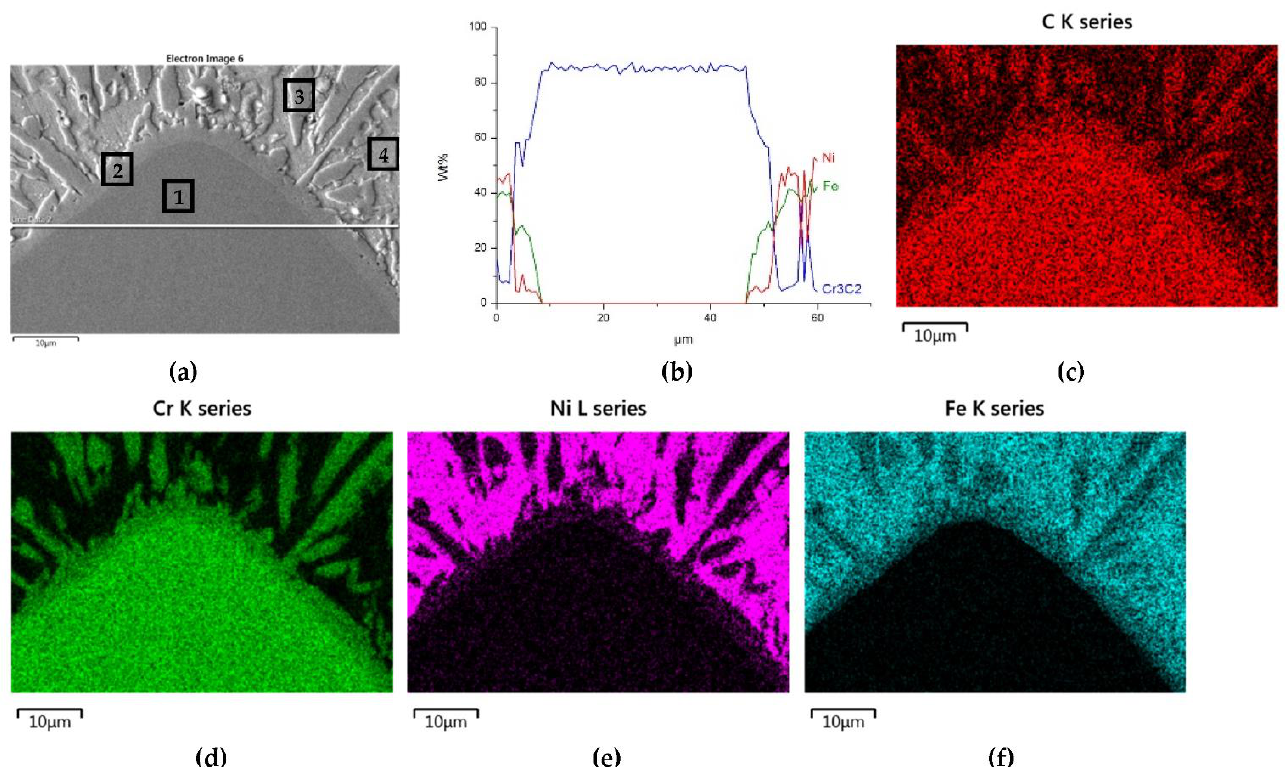
Figure 13. NiBSi-Cr 3 C 2 layer: SEM micrograph with points of the quantitative analysis marked ( a ), the linear concentration of main components along the marked line ( b ) and the maps of C ( c ), Cr ( d ), Ni ( e ), and Fe ( f ) distribution.